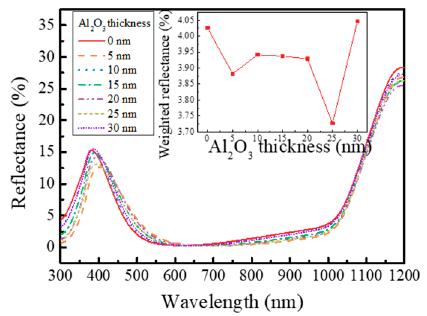
Figure 5. Reflectance from fabricated Al 2 O 3 -deposited SHJ solar cells where the inset figure shows calculated weighted reflectance.